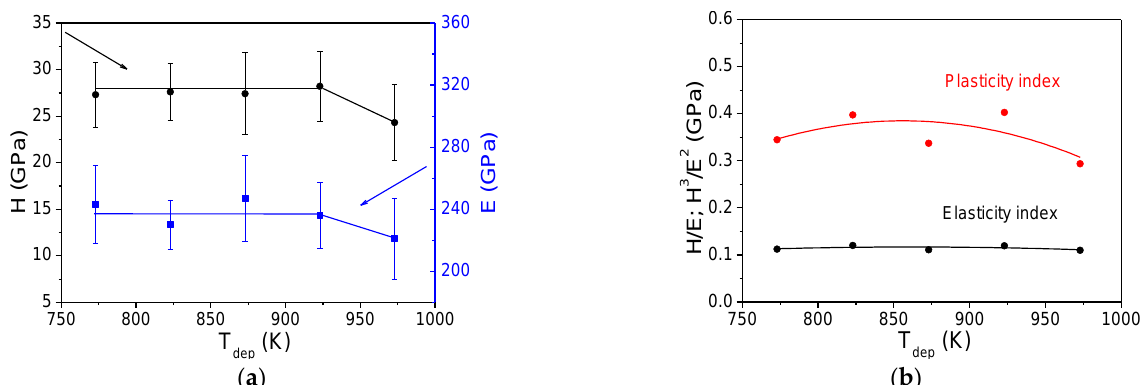
Figure 12. Temperature dependencies of ( a ) hardness, Young’s modulus, and ( b ) the elasticity index H/E and plasticity index H 3 /E 2 of LPCVD BC x N y films. Table 7. Mechanical properties of LPCVD BC x N y films. T dep ,